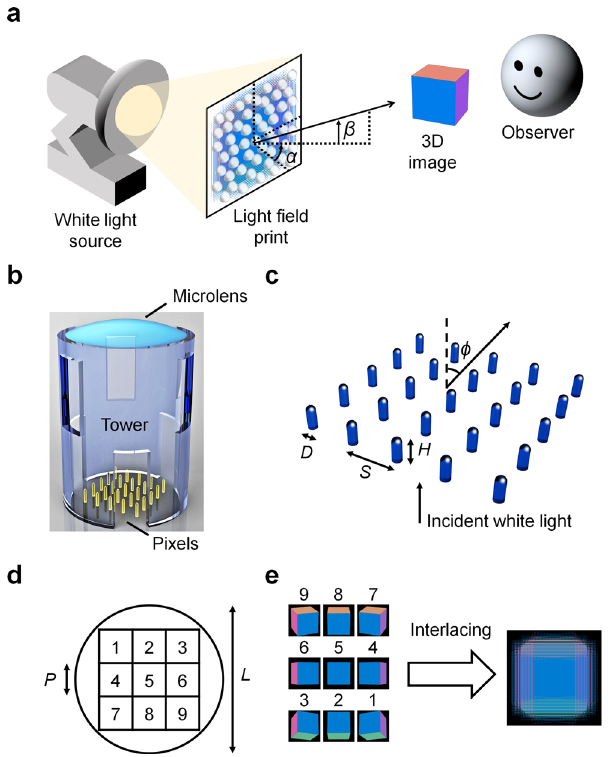
Fig. 1 Design of the light fi eld print. a Schematic that illustrates the working principle of our light fi eld print (LFP). A white light source is used to illuminate the structural colour pixels in the LFP. Transmitted light from the pixels is collected by the microlenses and projected to the far fi eld. An observer in the far fi eld sees a colourful 3D image from the viewpoint denoted by azimuthal angle α and elevation angle β . b Schematic of one display unit: A tower supports a spherical plano-convex microlens placed one focal length above a block of structural colour pixels that contains an array of nanopillars. c Schematic of one structural colour pixel that contains 5 × 5 nanopillars, in which each nanopillar has diameter D , height H and pitch S . ϕ is the viewing angle of the pixel. d Plan-view schematic of 3 × 3 pixels in a display unit. L is the diameter of the microlens, represented by a circle; P is the pitch of each pixel, represented by a square. Each pixel is assigned a number 1 – 9 and it is extracted from an input image assigned with the same number. e The input images are interlaced to generate a digital map of pixel positions for printing the